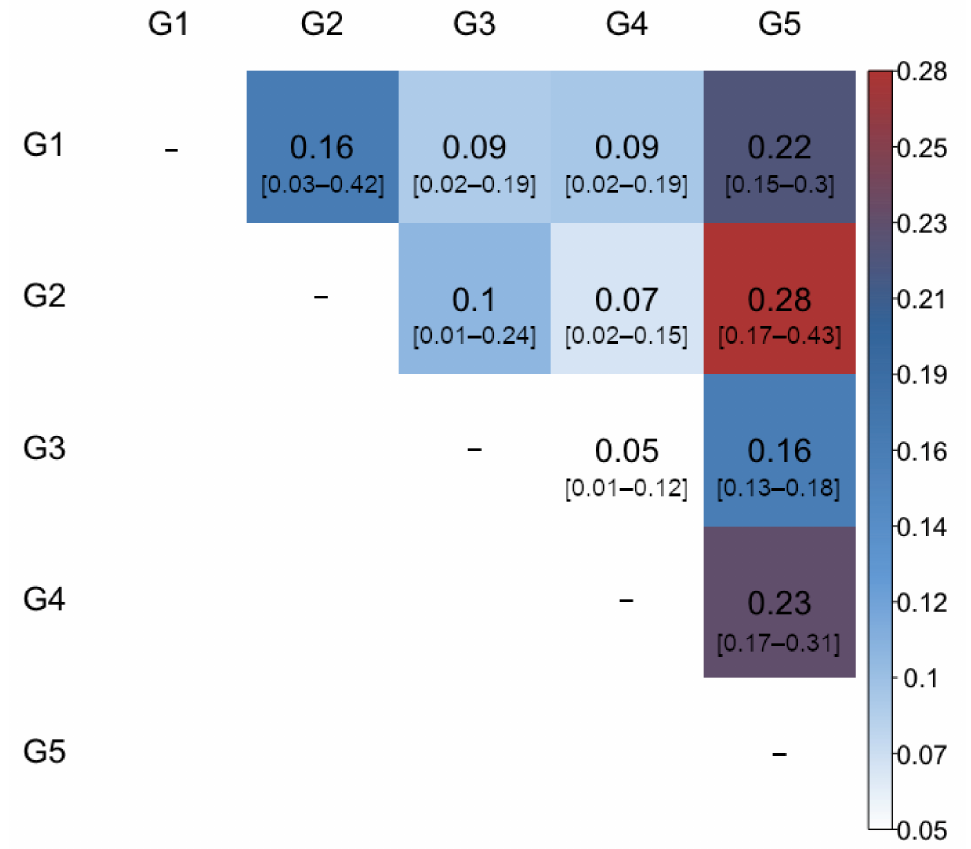
Figure 4. Correlation plot of pairwise genetic differentiation values ( FST ) among the five groups inferred by DAPC ( K = 5). Lower and upper limits of the 99% confidence interval based on 1000 boot- strap replicates are shown in